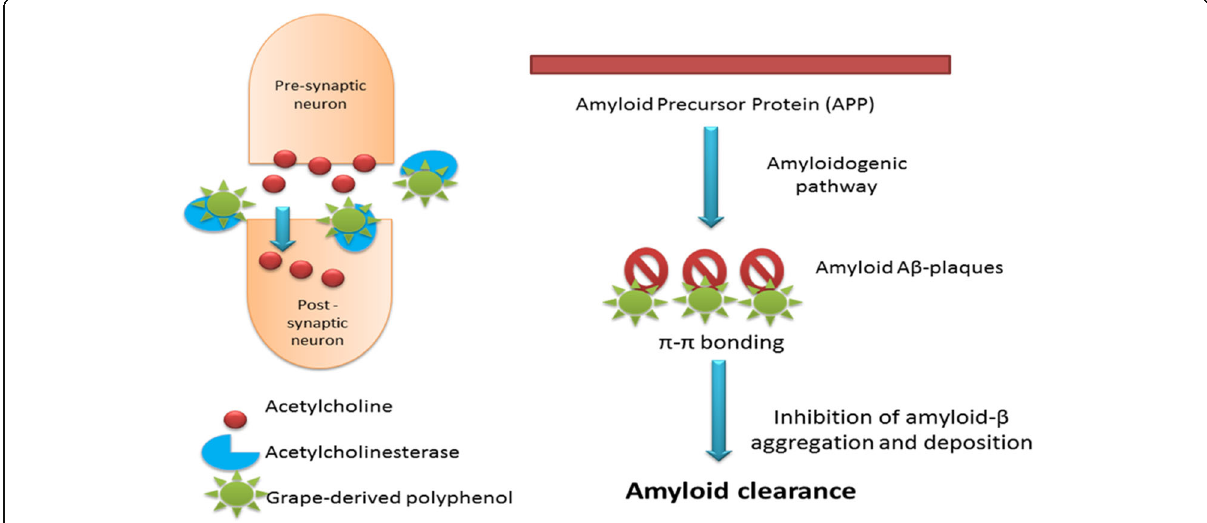
Fig. 2 Neuromodulatory role of grape polyphenols: grape-derived polyphenols could act as AChE inhibitors by binding to active sites of AChE and increasing neurotransmission mediated by acetylcholine (ACh), and as A β -42 inhibitors through inhibiting A β -oligomerization and promoting A β